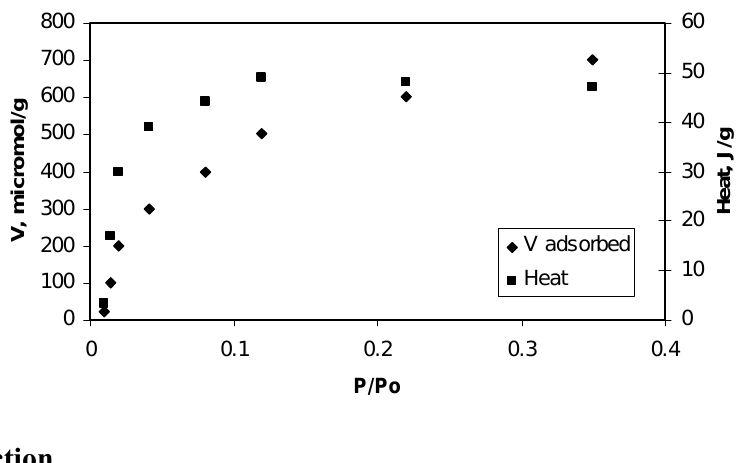
Figure 4. Heats absorbed for ammonia in function of relative